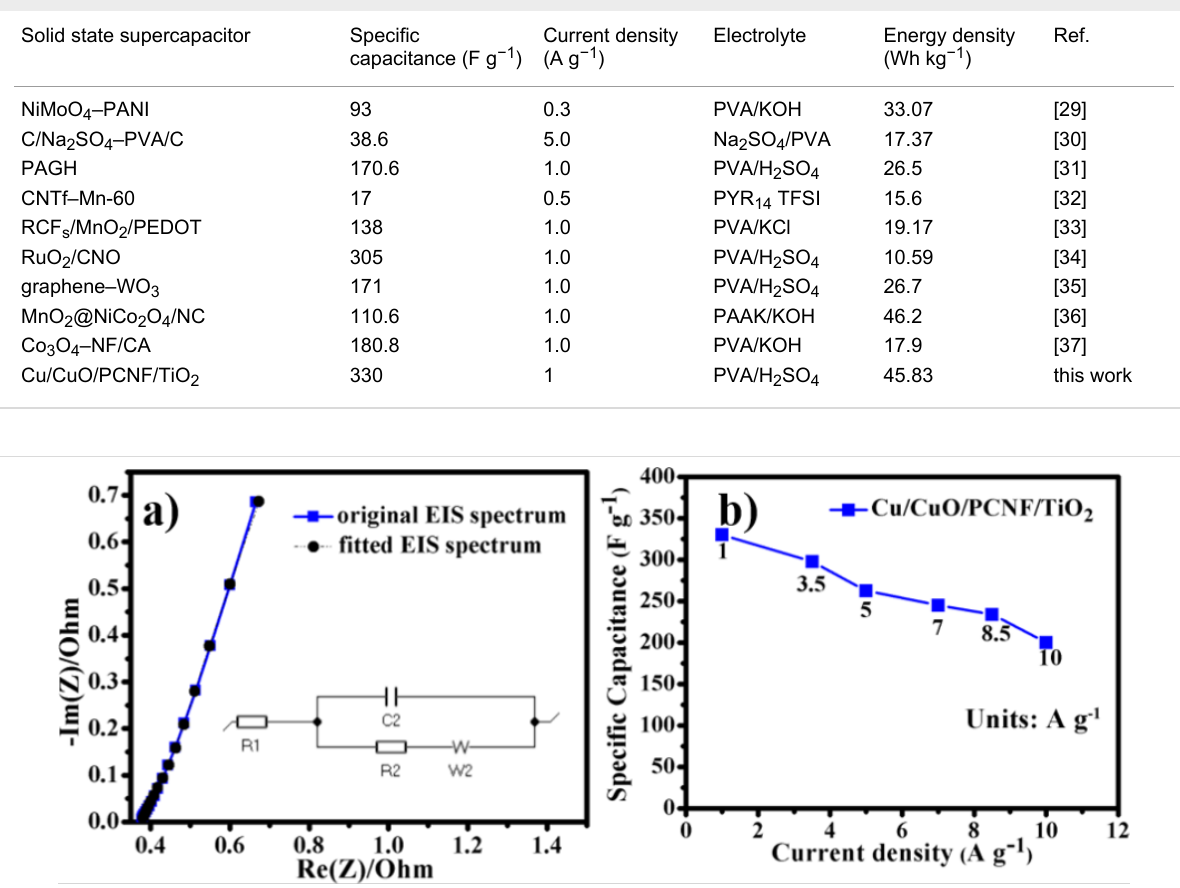
tical application. Figure 13 shows the cycle stability perfor- mance of the SSHSC measured by GCD for 10,000 cycles at a current density of 5 A g − 1 . We observed a capacitance